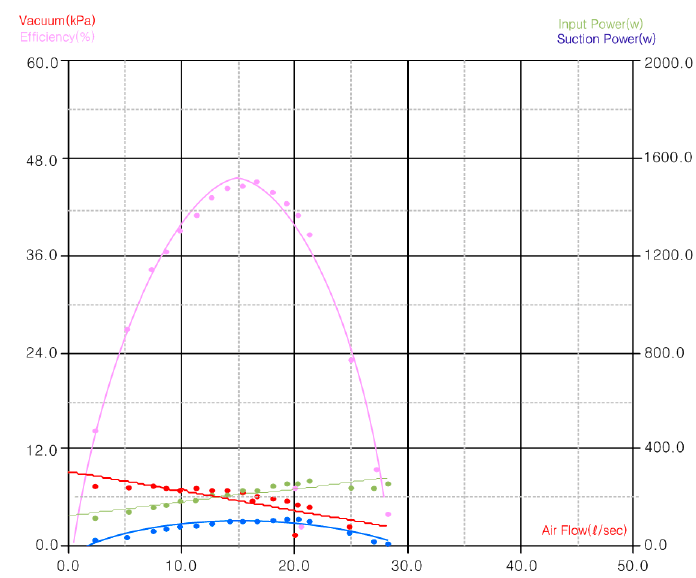
Figure 23. Prototype two ‐ phase 4/2 pole SRM suction power graph.